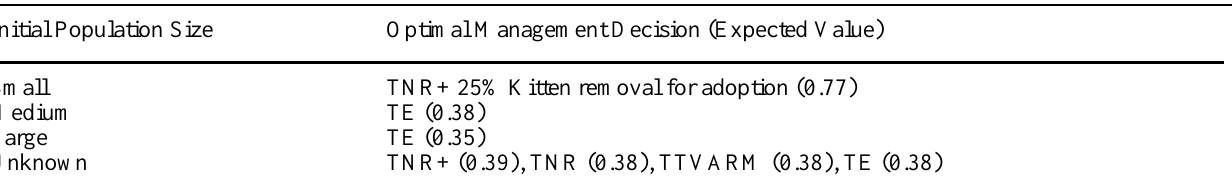
Table 6 . Optimal management decisions for populations under Small, Medium, Large or unknown population